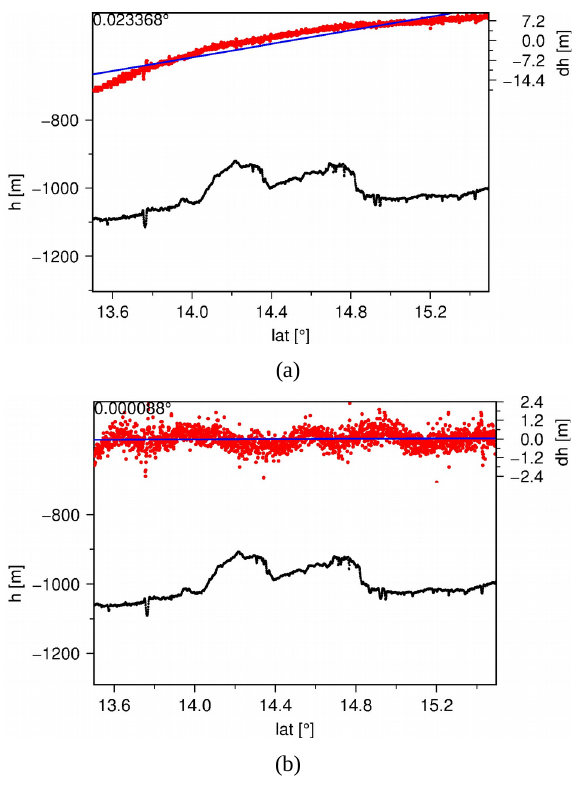
Figure 8: Comparison of height residuals (red) of LOLA shots of track #8498 with the adjusted LROC NAC DTM before (a) and after adjustment (b). The corresponding profile (black) is given to provide an overview of the local topography. An initial tilt of the NAC DTM of ~0.023° (a) in along track direction (approximated by the blue line) was eliminated by the BA (b). Elevation is given relative to the mean lunar radius of 1737.4 km.